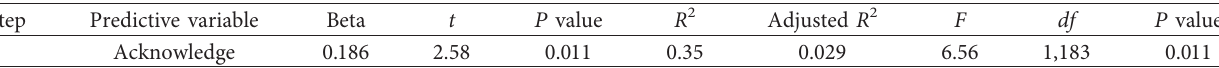
Table 6: The impact of nurses’ knowledge on their organ donation